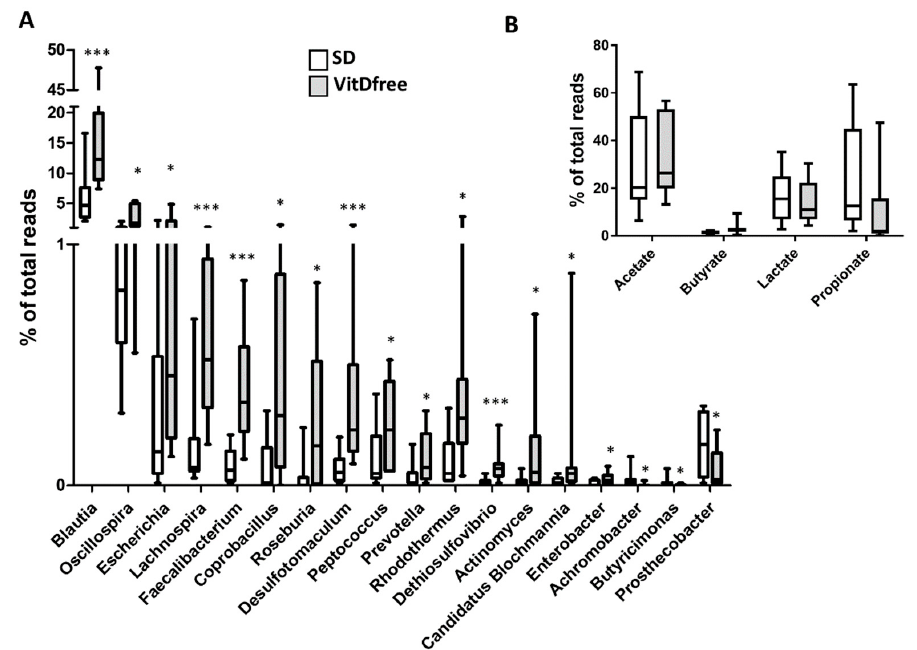
Figure 6. Effects of vitamin D-free diet on the relative genera abundance. ( A ) The most significant changes at the genus level are shown as a percent of total reads and represented in a box and whiskers plot for the standard diet (SD, n = 10) and vitamin D-free diet group ( n = 10). ( B ). The relative proportions of acetate, butyrate, lactate and propionate producing bacteria in the gut microbiota. Sequence reads were classified according to the primary end product of the assigned bacterial genera. Genera were classified into more than one group correspondingly if they were defined as producers of multiple metabolites. Results were compared by student’s t-test; * p < 0.05, ** p < 0.01 and *** p < 0.001 vs. SD.